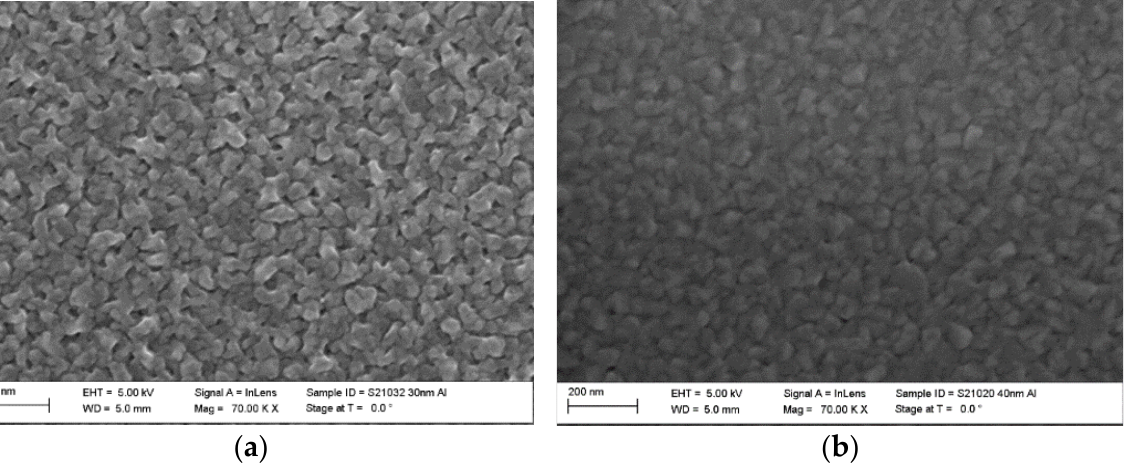
Figure 4. SEM image of a 62 nm ( a ) and 40 nm ( b ) thick aluminum film on fused silica glass prepared by electron beam evaporation with plasma assistance (series 3). The bad quality of the SEM image of the thinner sample is due to the electric charging of the sample, caused by the insulating substrate and the lower film thickness.